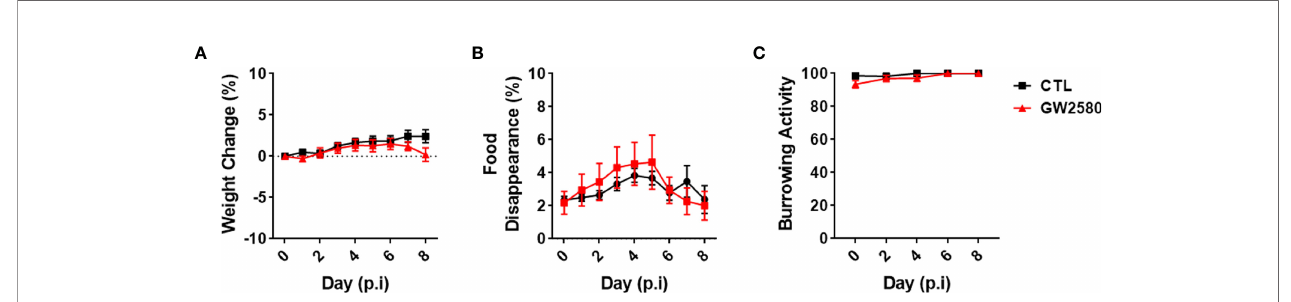
FIGURE 1 | Effect of GW2580 treatment on mouse weight and behavior. (A – C) Mice were treated with GW2580 at a dose of 80mg/kg/d by oral gavage for 8 days. The effect of treatment on weight (A) , food disappearance (B) , and burrowing activity (C) is shown. Data are expressed as means ± standard error (S.E.). Each group is composed by n=30 per group from four independent experiments for weight change, n=6 per group from a single experiment for food disappearance, and n=15 per group from three independent experiments for the burrowing